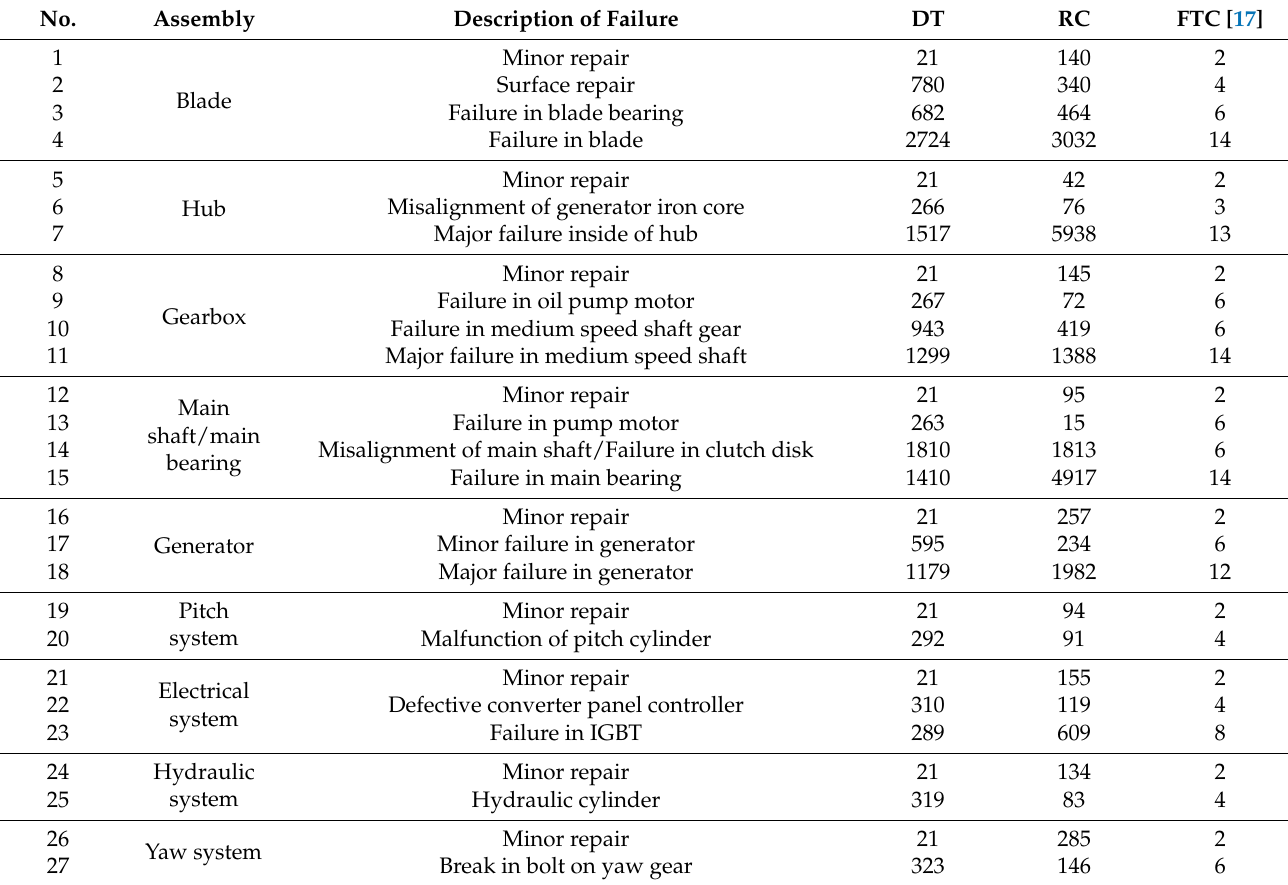
Table 4. Description of each FTC for NEDO failure